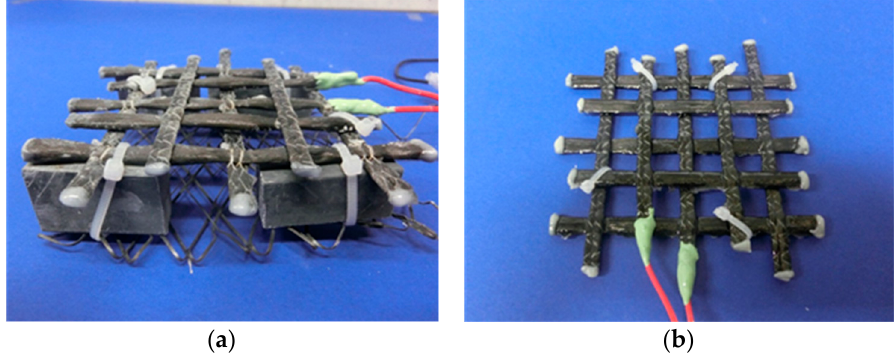
Figure 2. Specimen with S4 anode, spacers and titanium electrode ( a ) and an E4 anode ( b ).